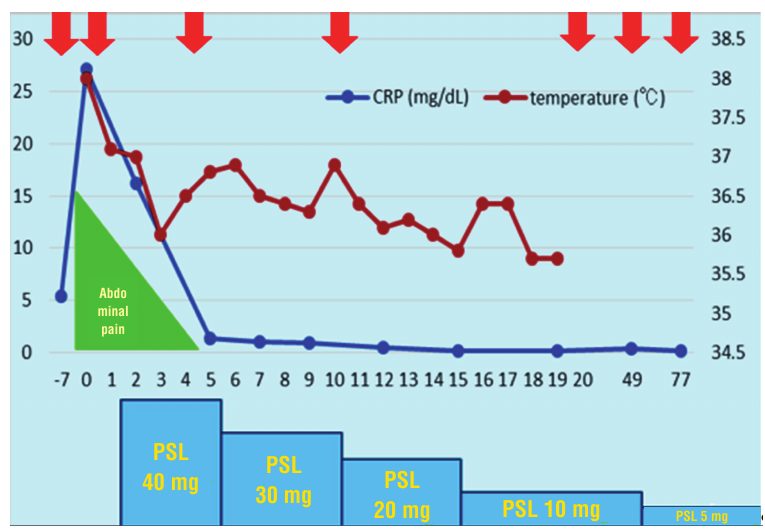
figure 4 - clinical course (arrow: